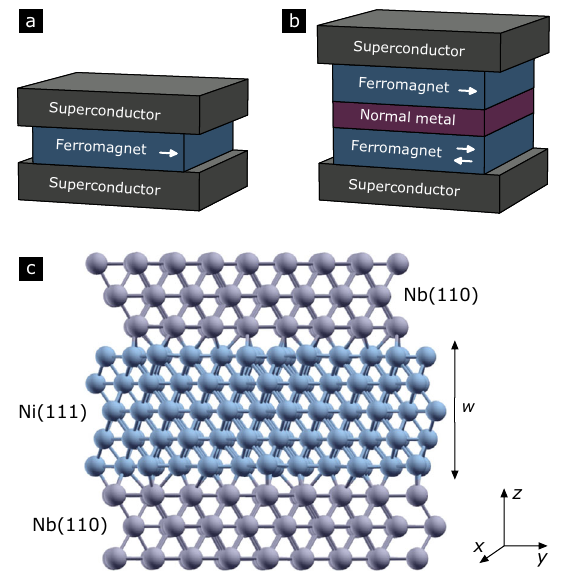
Fig. 1 MJJ stacks. a Schematic view of the SFS junction. b SFNFS junction. Arrows indicate possible magnetization of ferromagnets. The supercurrent through the spin-valve JJ depends on the relative magnetization of the ferromagnets, which governs the properties of the Josephson magnetic random-access memory (JMRAM) 16 . c Ball- and-stick representation of the Nb(110)/Ni(111)/Nb(110) junction with fi ve layers of Ni. Nb atoms are light grey, Ni atoms are blue. The top and bottom atomic planes of Nb(110) are repeated periodically in the z -direction to create the semi-in fi nite Nb leads of the junction through which the current fl ows. Periodic boundary conditions are used in the xy -plane. The corresponding reciprocal space de fi nes two-dimensional k ∥ = ( k x , k y ) vectors, i.e., the transverse modes, used in the calculations.